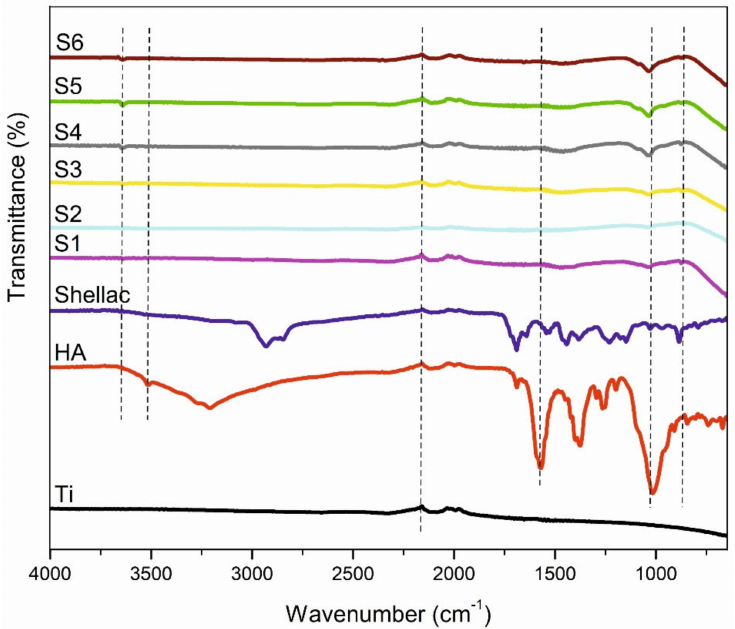
Figure 3. FT-IR spectra of the initial materials (titanium; hydroxyapatite; shellac) and the Ti-HA composites